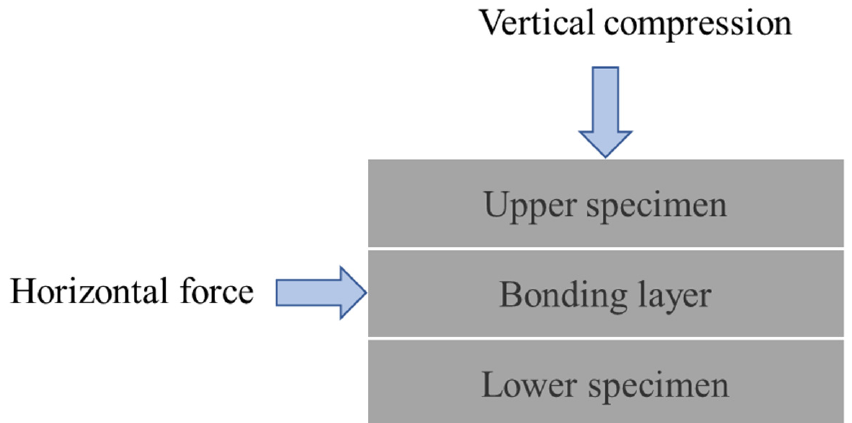
Figure 6. Schematic diagram of the specimen (actual thickness of bond layer is very thin, which can be considered as no thickness). be considered as no